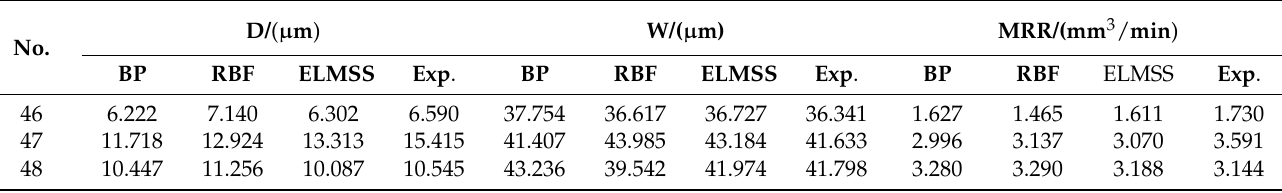
Table 5. Measured value and prediction results of the three types of